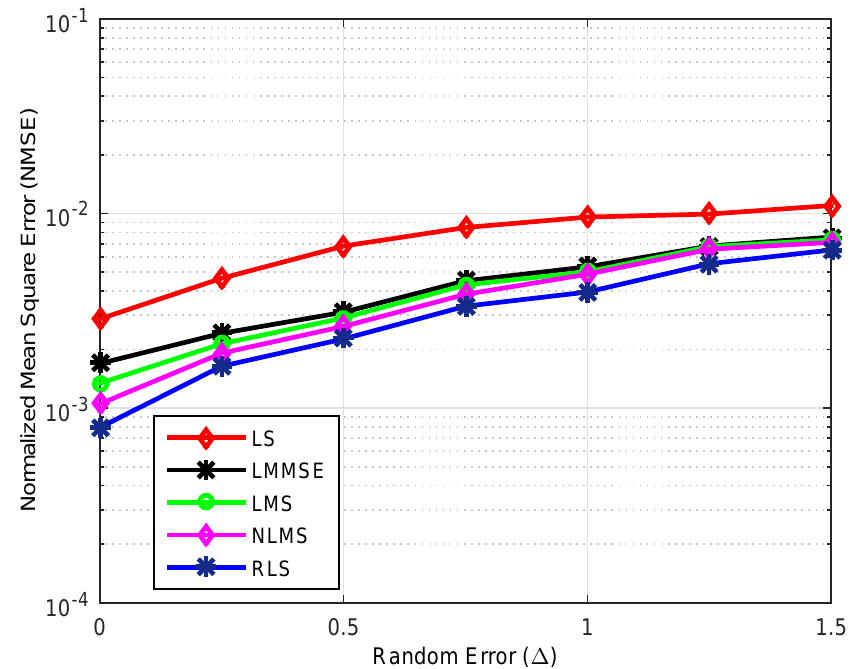
Figure 22. Performance comparison in terms of NMSE versus Non-PR error at SNR = 5